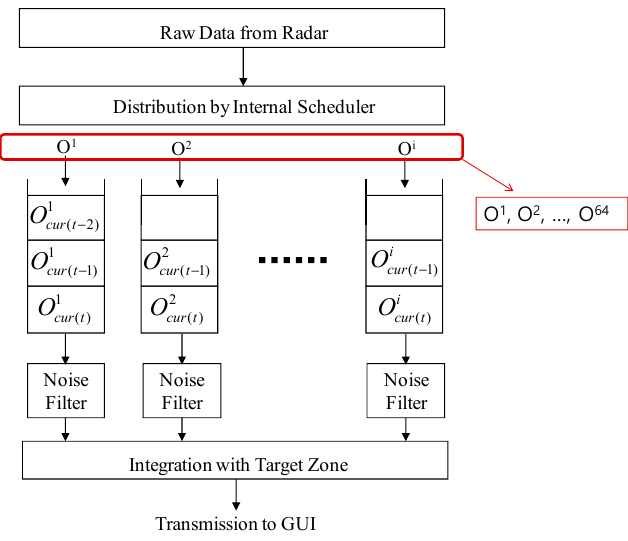
Figure 13. Separate queue architecture of the RWM.